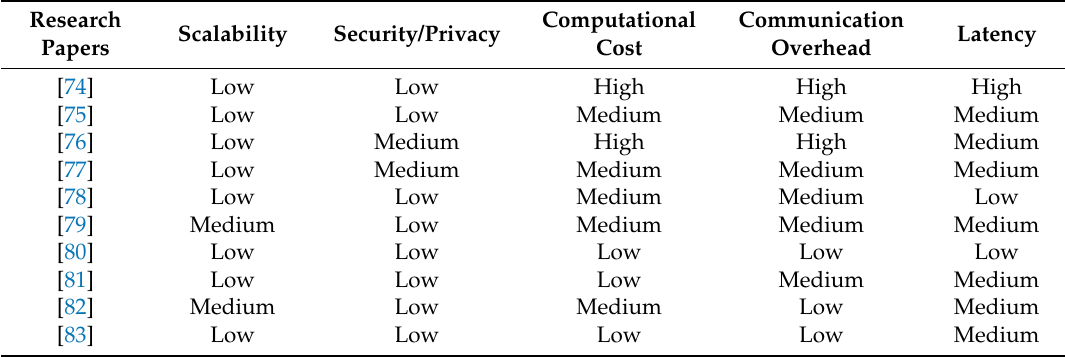
Table 1. GSB/RSB schemes